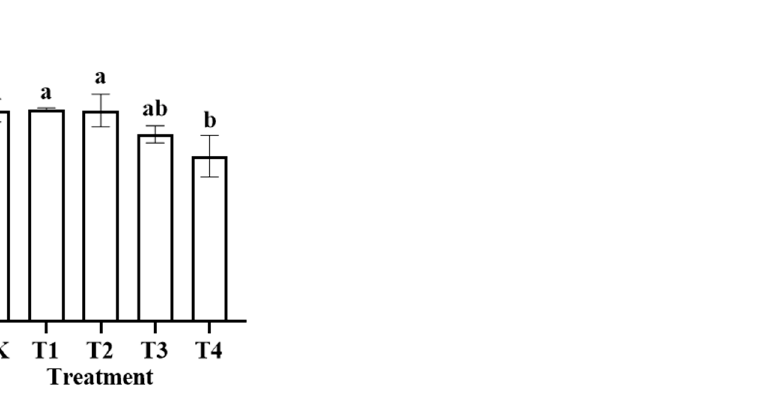
Figure 7. Effect of reducing the application of different doses of fertiliser before harvesting on the yield of pepper. The yield of peppers represented the total yield from six harvests during the experimental period. Different letters indicated significant differences between treatments at p of 0.05 according to Tukey’s multiple range test (n = 3). With no fertiliser reduction as the control (CK), the T1, T2, T3 and T4 treatments represented 20%, 40%, 60% and 80% reduction in fertiliser application from 0 to 6 days before each harvest, respectively.